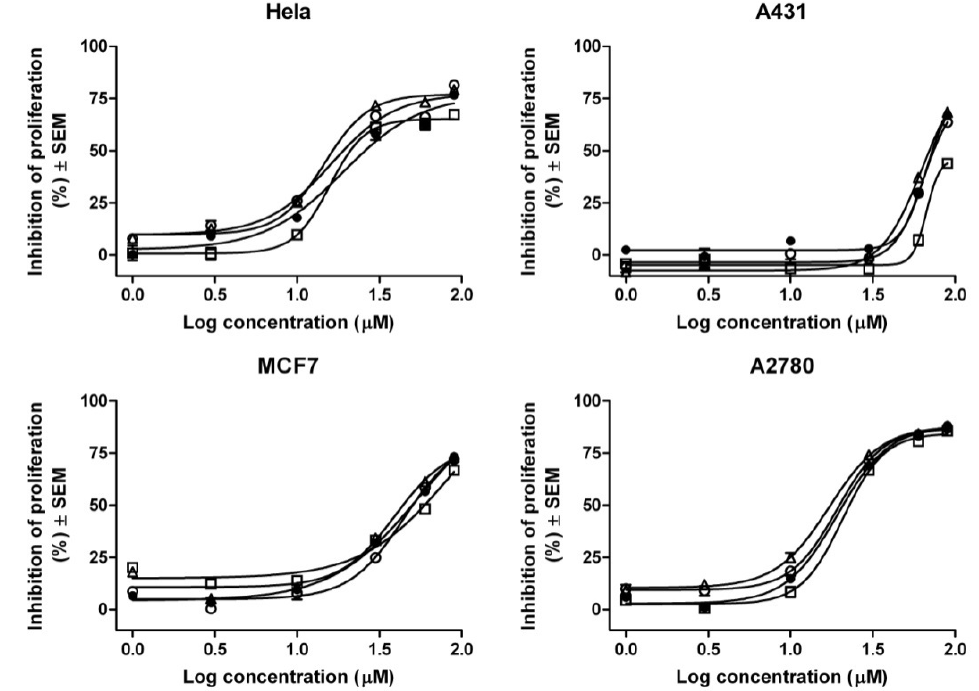
Figure 5. Dose-response curves of genistein (  ) and the tested complexes prepared with RAMEB (  ), HPBCD ( Δ ) and HPGCD (  ) (1, 3, 10, 30, 60 and 90 µM) on four different human cancer cell lines: Hela, A431, MCF-7, A2780.